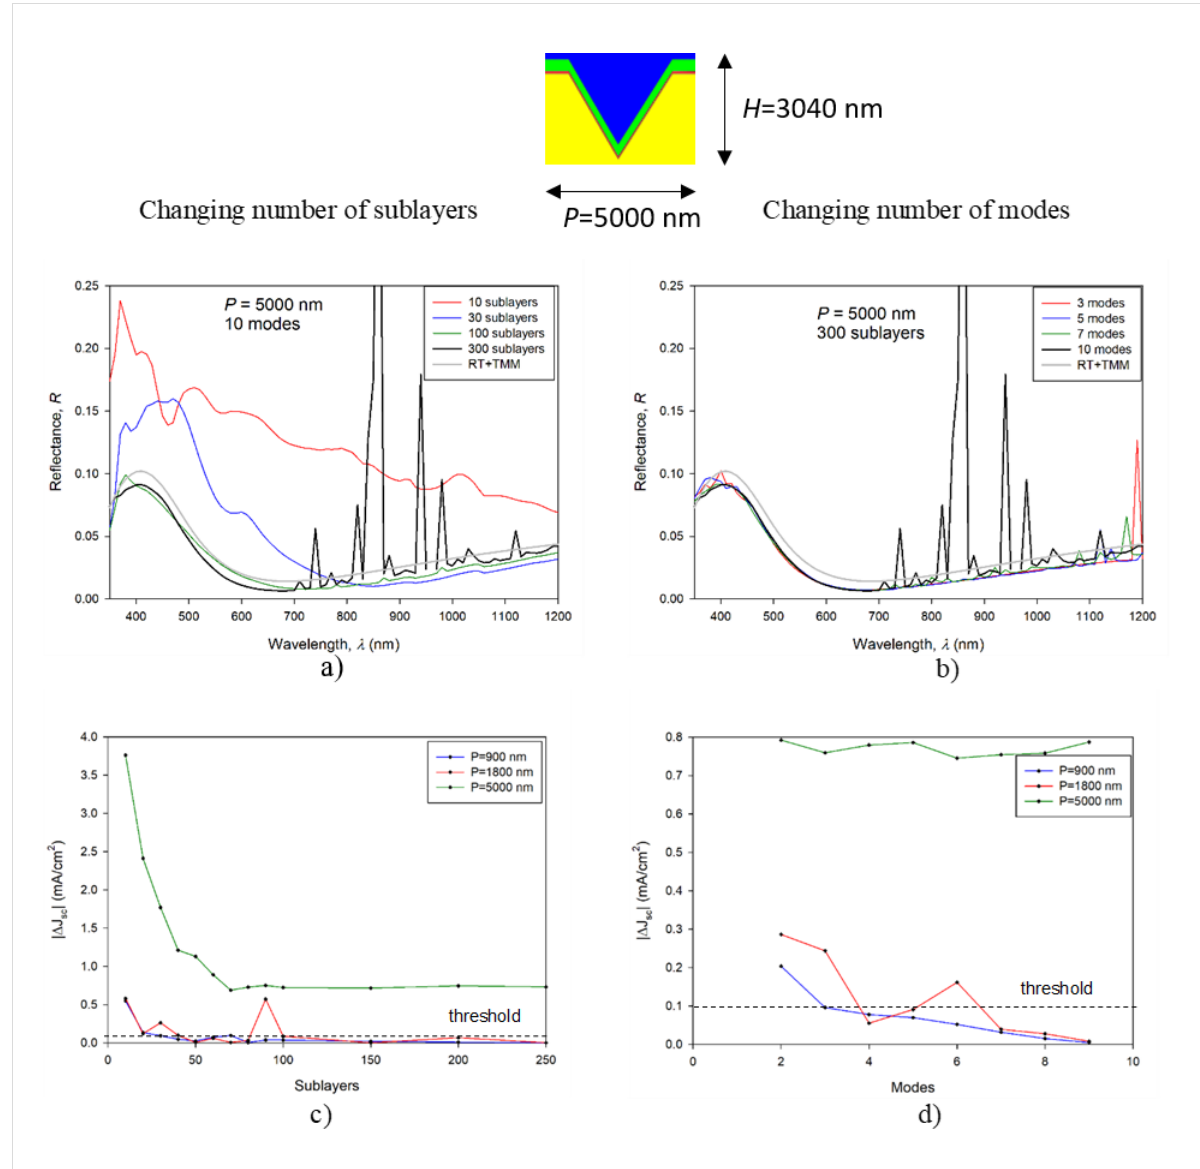
Figure 6: Analysis of RCWA convergence for micrometer-sized textures. Left hand side graphs correspond to the results of variation of the number of sublayers with a fixed number of modes, while the right hand side graphs correspond to the results of variation of the number of modes with a fixed number of sublayers. The top two graphs (a, b) show visual pyramidal texture convergence with number of sublayers and modes. Graphs (c) and (d) quantify the difference between the RCWA results using the | Δ J SC |